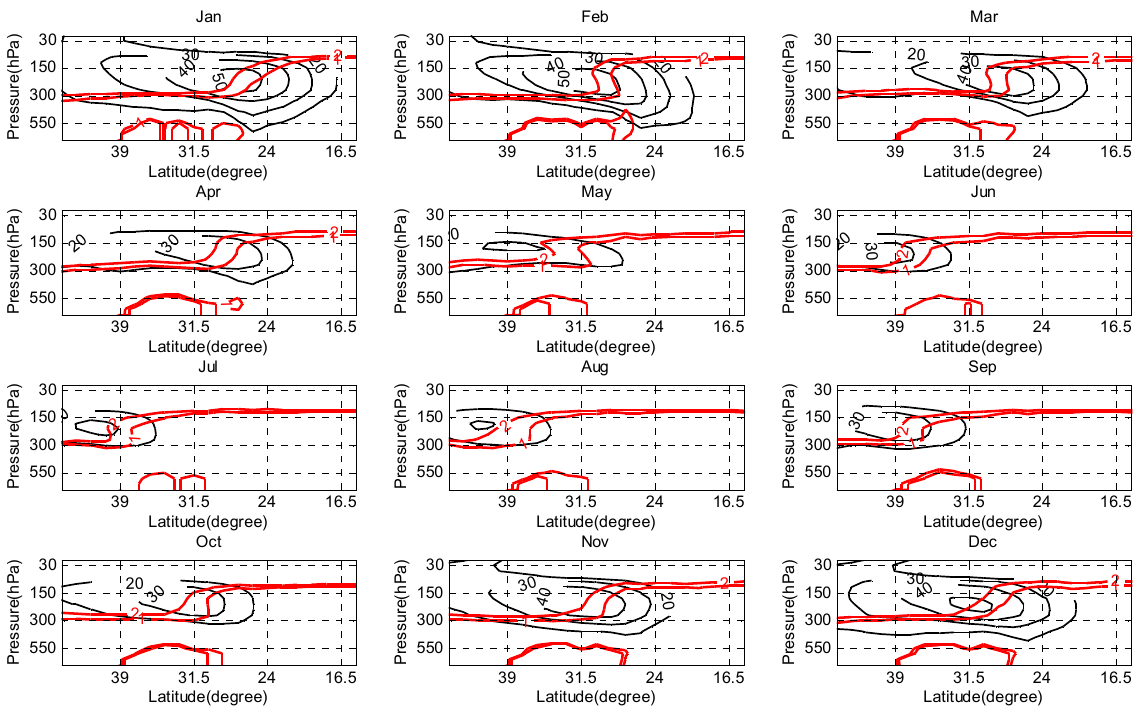
Fig. 7. Pressure-latitude cross-section of monthly average zonal wind (black contours, ms − 1 ) and potential vorticity (PV) (red lines, contours of 1–2 PVU units) at 90 ◦ E between 15 ◦ N and 45 ◦ N in latitude and between 1000hPa and 20hPa in the vertical derived from ERA-40 data Fig. 7. Pressure–latitude cross section of monthly average zonal wind (black contours, m/s) and of potential vorticity (PV) (red lines, contours of 1–2 PVU units) at 90 。 E between 15 。 N and 45 。 N in latitude and between 1000 hPa and 20 hPa in the vertical derived from ERA-40 data of 2008.